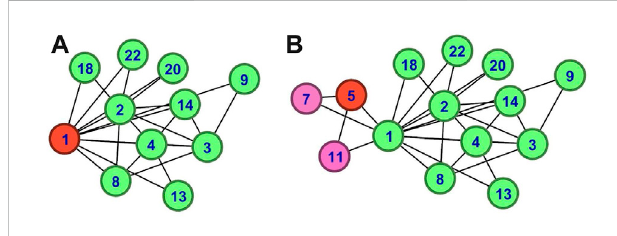
FIGURE 4 An example of community initialization and community expansion of seed v 1 . (A) The initial community of seed v 1 . (B) The process of identi fi cation on the membership of node v 5